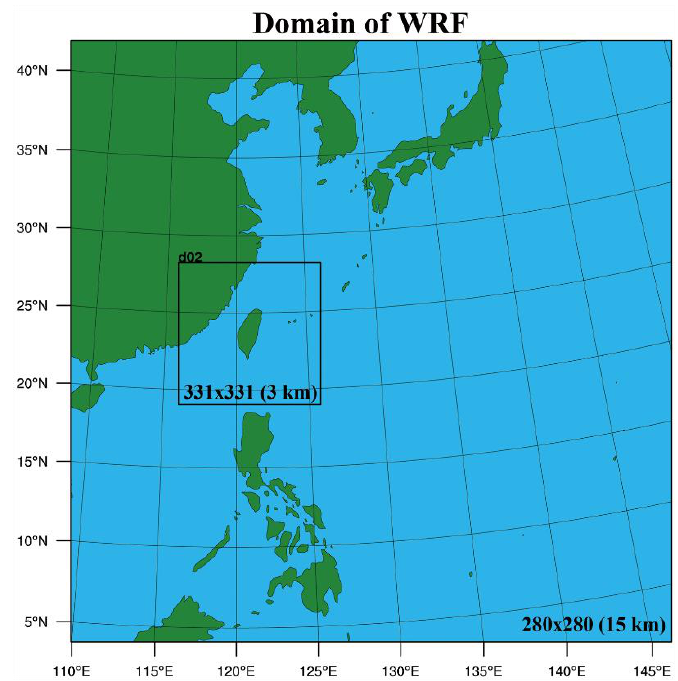
Figure 2. The two-way interactive, double-nested simulation domains of the Weather Research and Forecasting (WRF) model. Domains 1 and 2 have 280 × 280 and 331 × 331 horizontal grid points with 15 and 3 km spacing, respectively.